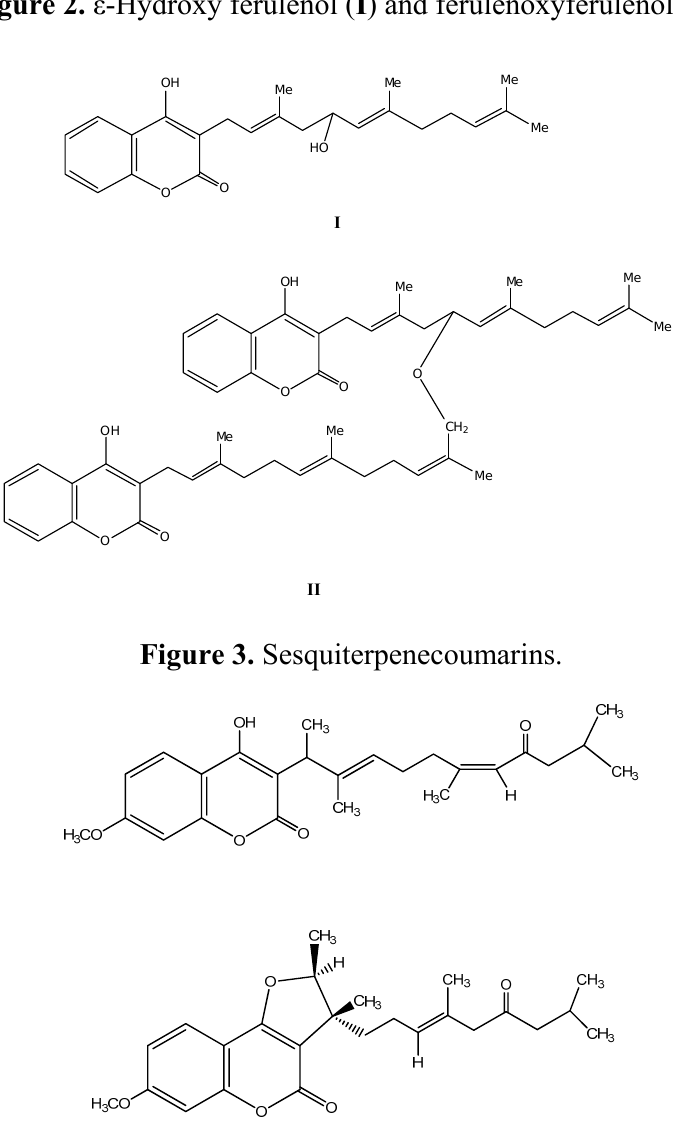
Figure 2. ε -Hydroxy ferulenol ( I ) and ferulenoxyferulenol ( II ).